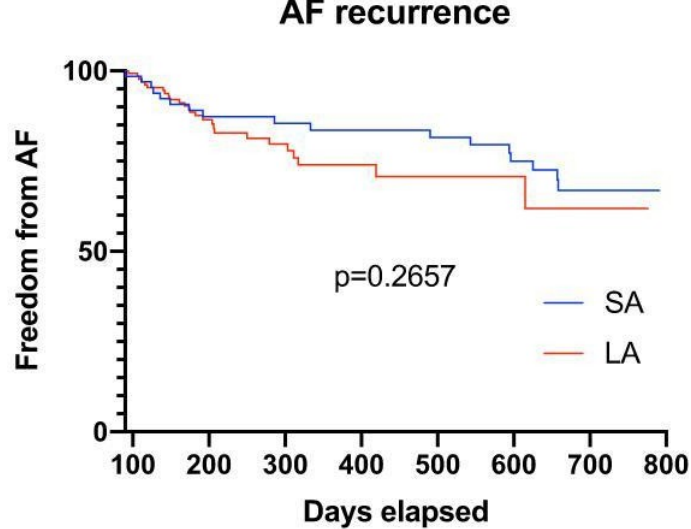
Figure 4. Survival plot of patients after a mean follow-up of 354 days, showing no significant difference with regard to late recurrence of AF in both groups (after a blanking period of 90 days).